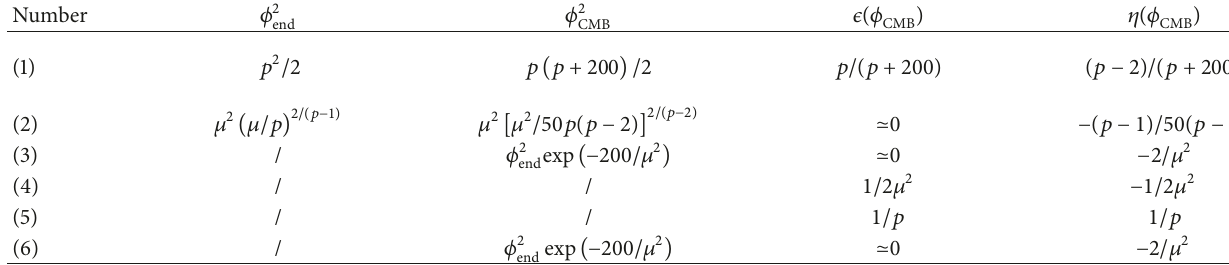
Table 2: Slow-roll parameters for each model [19].